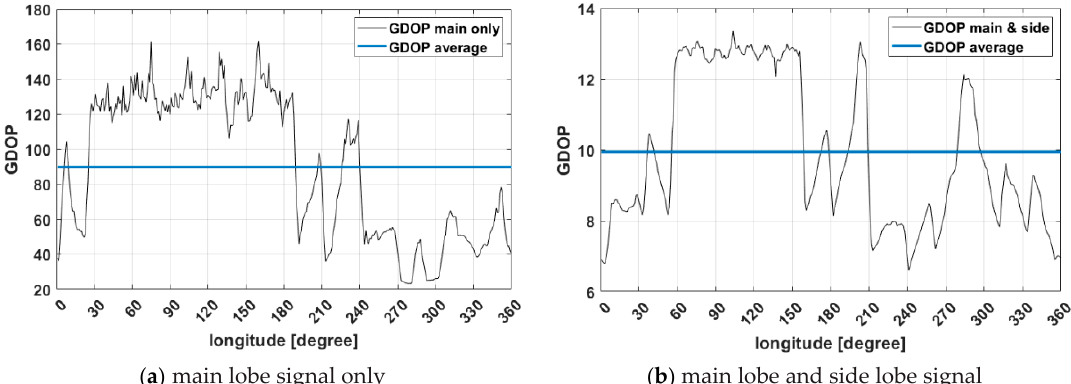
Figure 7. Geometry dilution of precision for 24 h in geostationary orbit with longitude.